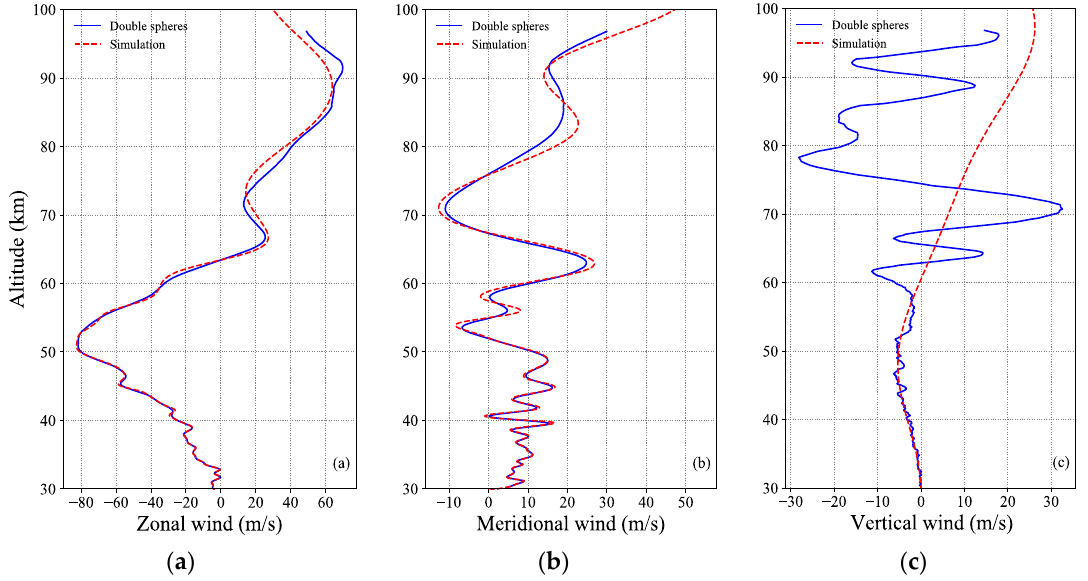
Figure 6. Comparison of smoothed 3D wind field inversion results with the simulated wind field. ( a ) Zonal wind; ( b ) meridional wind; ( c ) vertical wind.